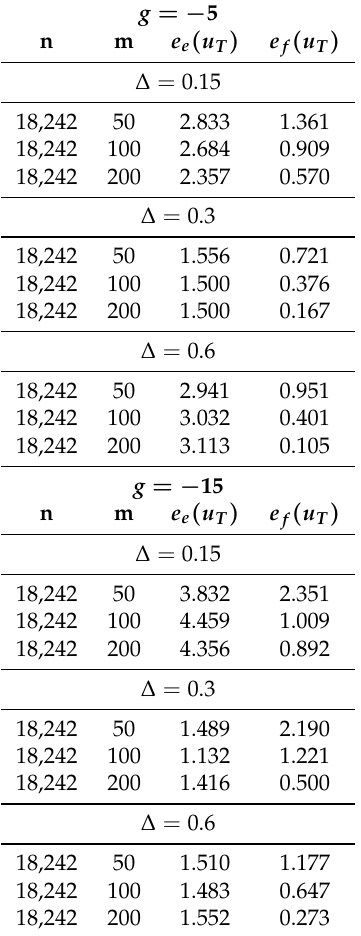
Table 9. Geometry with the unstructured grid with delta-smoothing. Relative L 2 error for the temperature at the final time and phase change interface location with respect to the exact solution and a very fine grid solution. g = − 5 n m e e ( u T